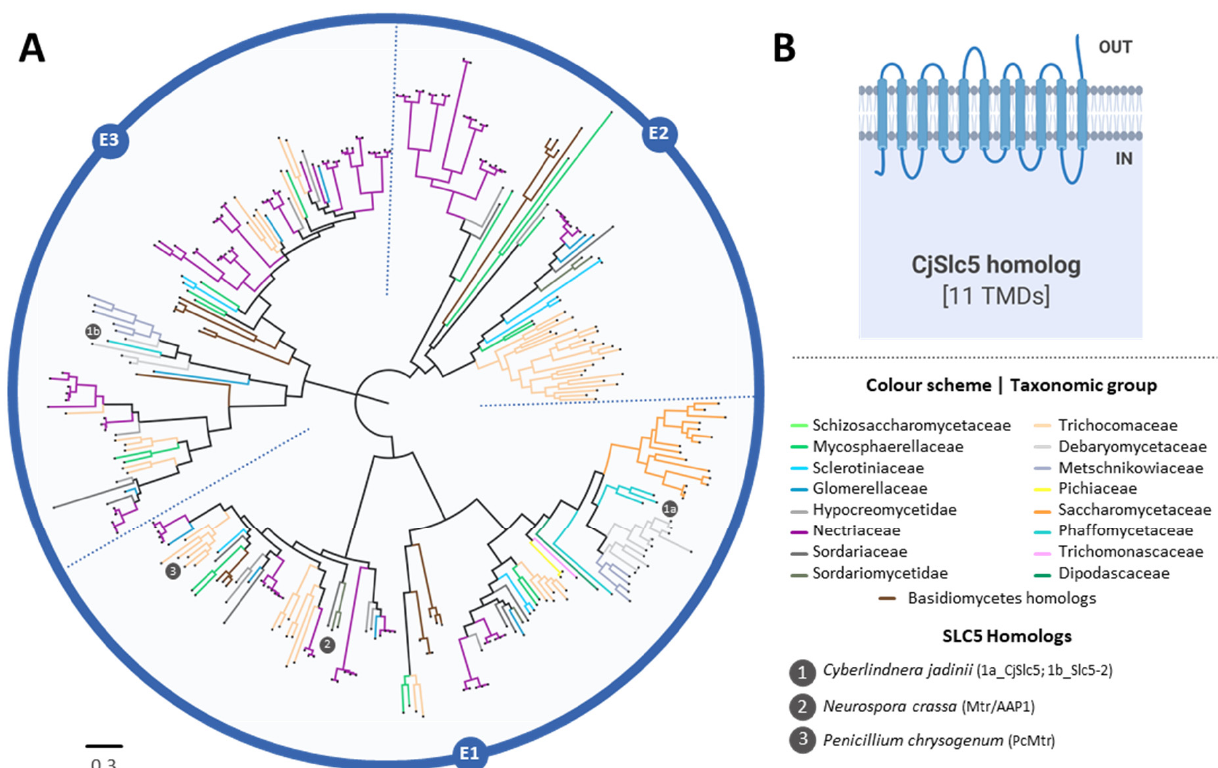
Figure 8. Maximum likelihood phylogenetic tree of SHS family members (TCDB 2.A.1.12). ( A ) Groups indicated as E1, E2, and E3 for eukaryotic clades and P1 and P2 for prokaryotic clades were established to enable the following of the tree description in the main text and are not meant to provide any type of classification. Major taxonomic groups are indicated in shades of blue— bacteria; orange—ascomycetes; brown—basidiomycetes; and green—archaea. Homologs relevant for the discussion through the manuscript are highlighted. ( B ) A simplified scheme of Jen1 native and CjJen proteins with inferred substrate specificities is depicted.